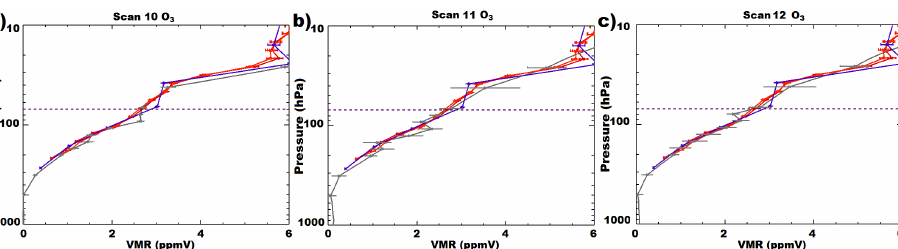
Fig. 9. Comparison of O 3 profiles retrieved from MARSCHALS scan 10 to 12 (grey) with MIPAS/ENVISAT (blue) and MLS/Aura (red) O 3 profiles. The horizontal dashed line represents the flight altitude level.